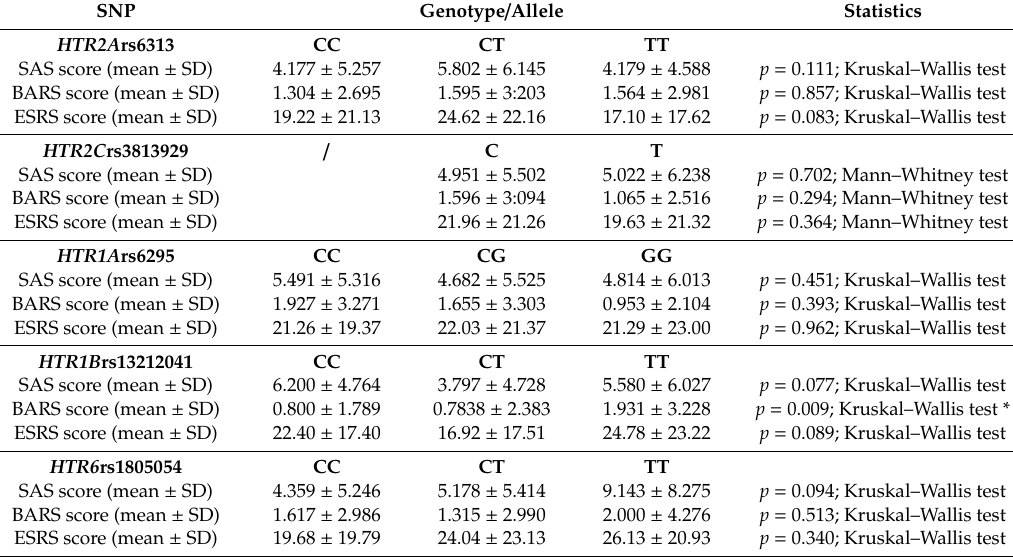
Table 4. SAS, BARS and ESRS total scores in haloperidol-treated schizophrenia patients carrying di ff erent genotypes or alleles of 5-HT receptor gene